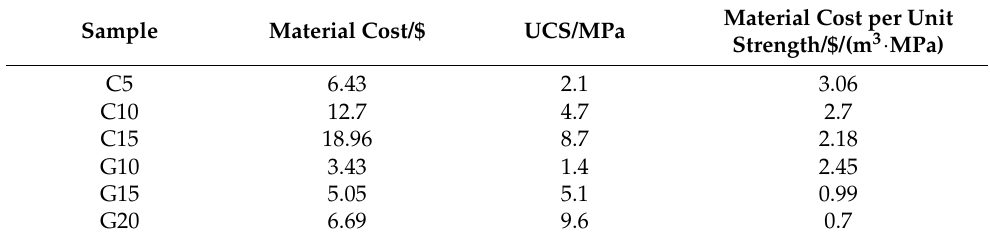
Table 7. Cost of cementing materials per cubic meter of stabilized aeolian sand reaching unit